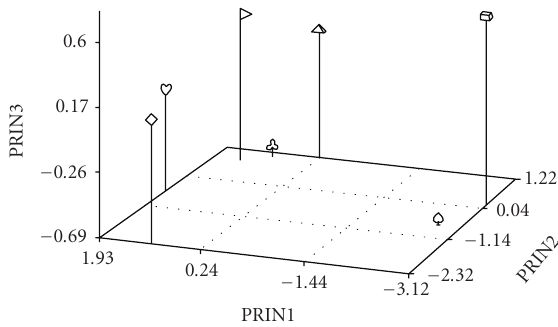
Figure 2: Ordination of Salix clones on three-dimensional princi- pal space based on the analysis of codominant (isoenzyme) genetic markers. Designations: pyramid: S259, heart: S267, club: S289, diamond: S301, spade: S353, cube: S354, flag: